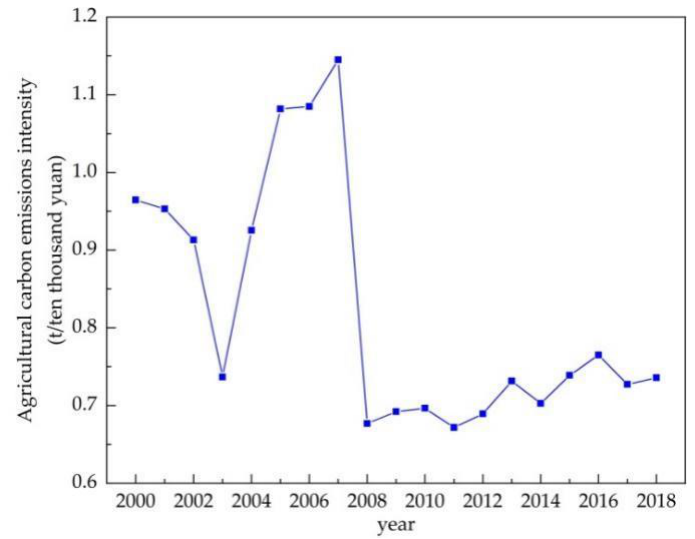
Figure 5. Agricultural carbon emission intensity in Jilin province during 2000–2018.